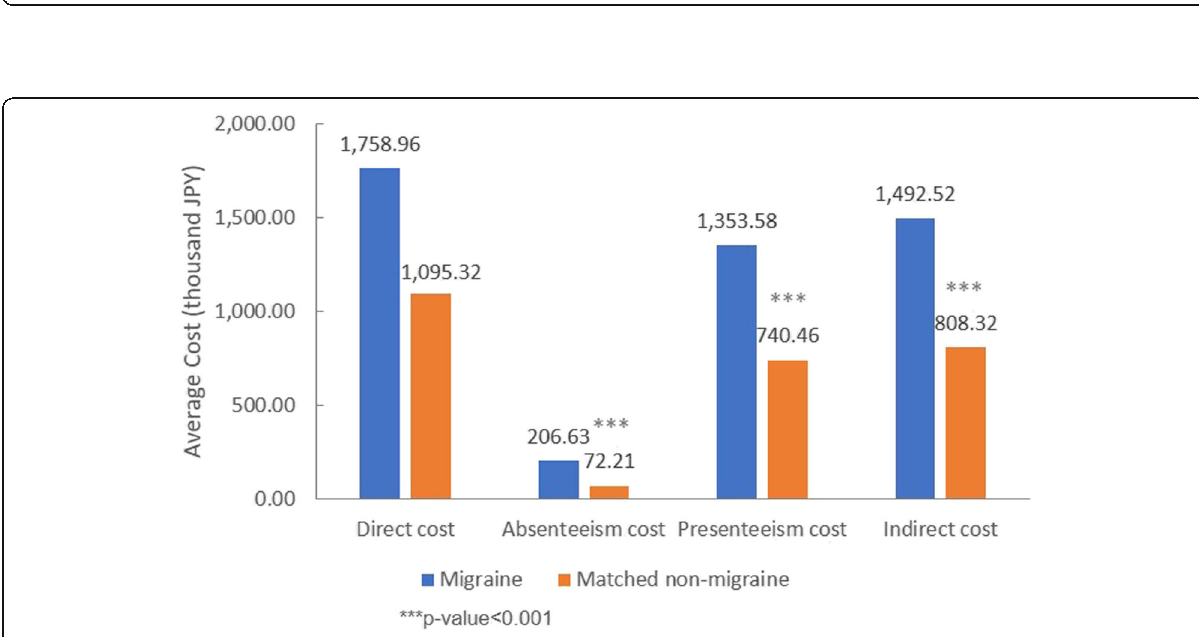
Fig. 4 Adjusted means of annual direct cost and annual indirect cost for migraine patients and matched non-migraine respondents. Adjustment for following covariates: age, gender, CCI, marital status, education, household income, region, insurance type, employment status, BMI, smoking status, alcohol use and exercise behavior. Abbreviations: JPY=Japanese